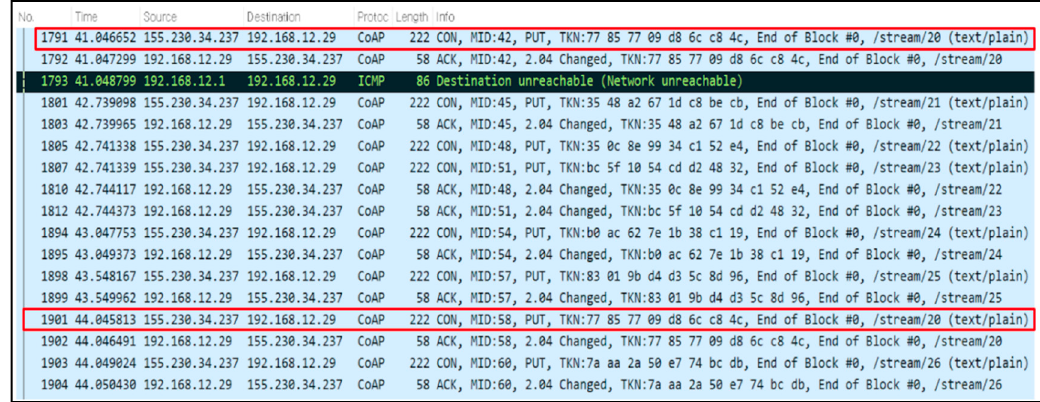
Figure 3. Packet analysis for error handling of CoAP over UDP.